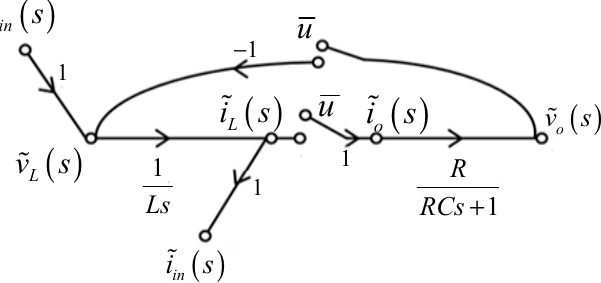
Figure 1. Switching flow graph representation of the conventional boost converter.